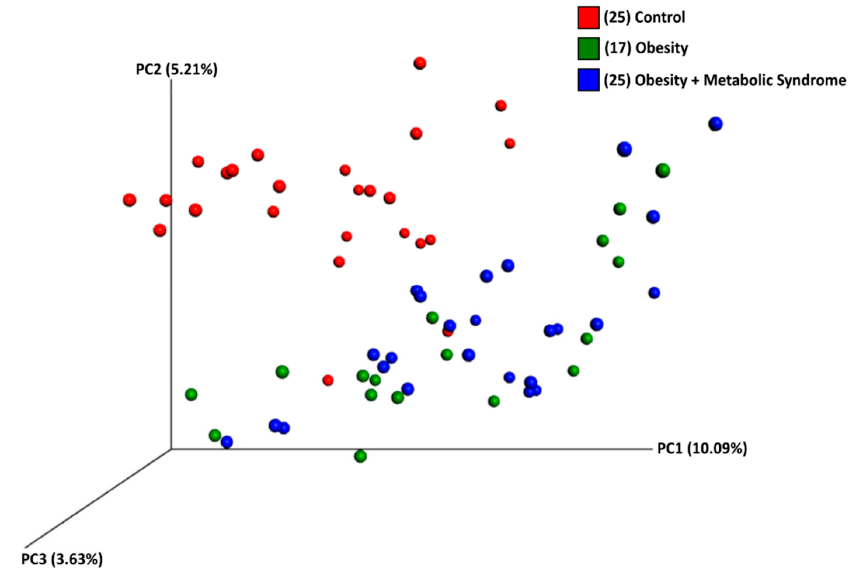
Figure 3. Bacterial beta diversity. The Figure shows a three-dimensional scatter plot, generated using principal coordinates analysis (PCoA) from Unweighted UniFrac analyses, showing the distance of microbial communities among women with normal weight (red spheres), women with obesity (green spheres), and obesity + metabolic syndrome (blue spheres). Each group is identified by colors as indicated on the right side of the figure. The p -value was calculated using ANOSIM method to compare beta diversities between each category in all samples, and between each category in a sub-sample controlled by age, using a distance matrix as the primary input and mapping file. Control, obesity, and obesity + metabolic syndrome have significant differences in all samples ( p -value 0.01), and in a sub-sample controlled by age ( p -value 0.02; see Table